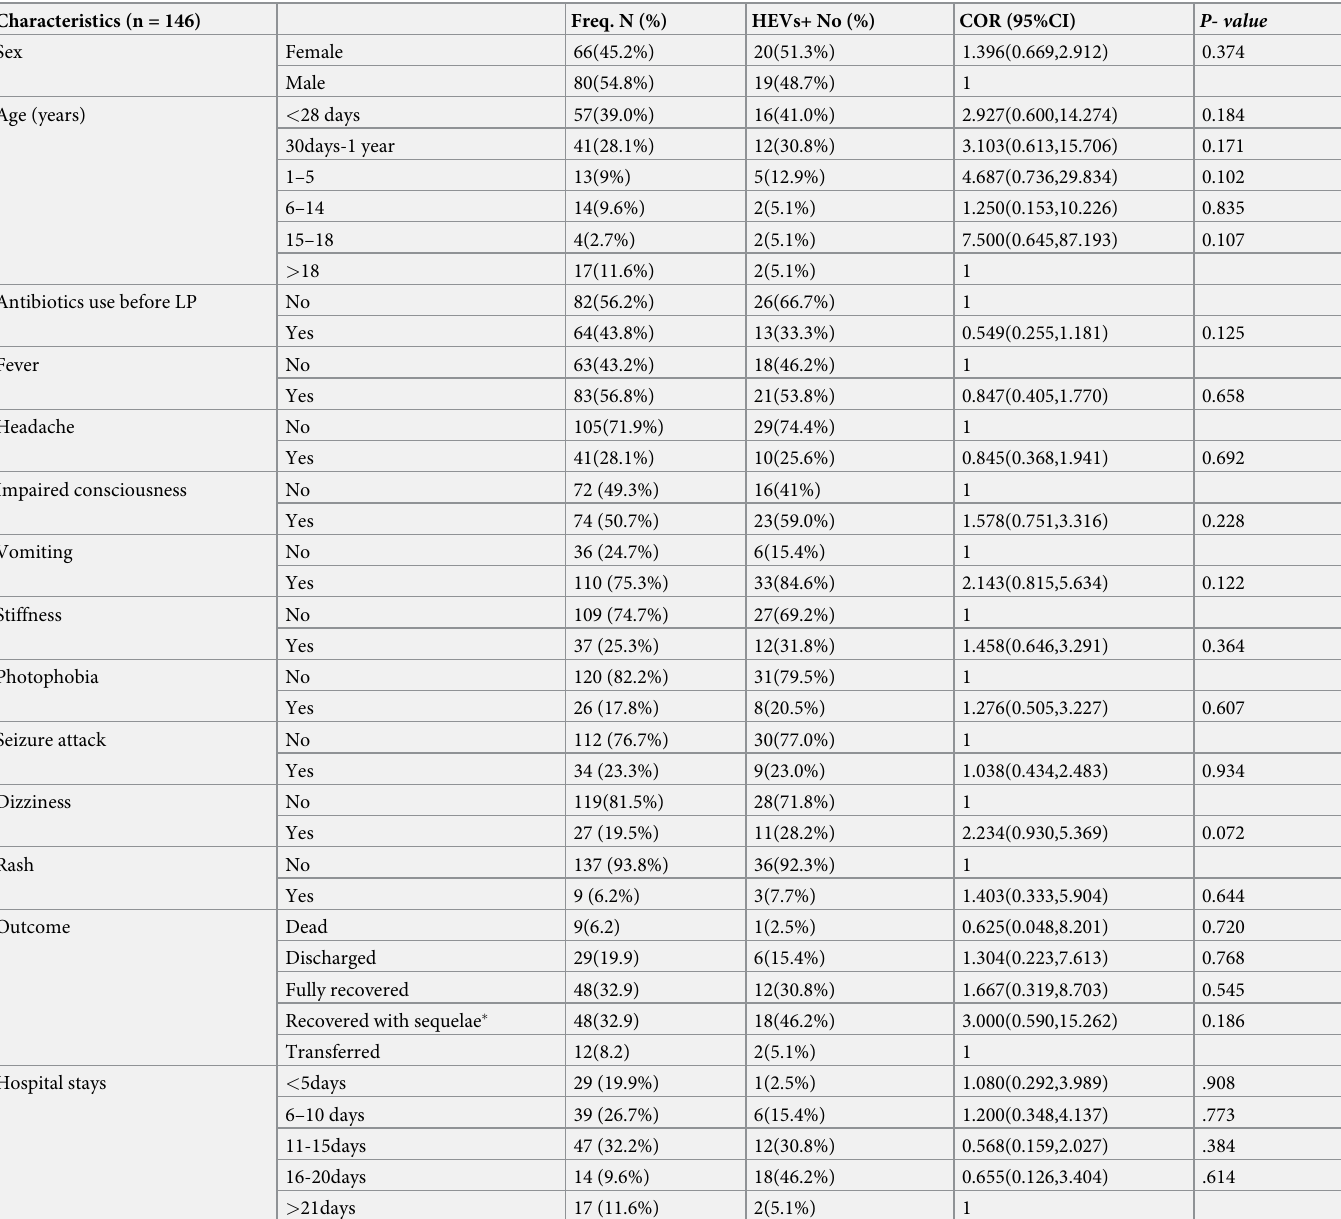
Table 1. Bivariate analysis of socio-demographic and clinical characteristics of patients with HEVs positivity at selected hospitals in Addis Ababa, Ethiopia. Characteristics (n =